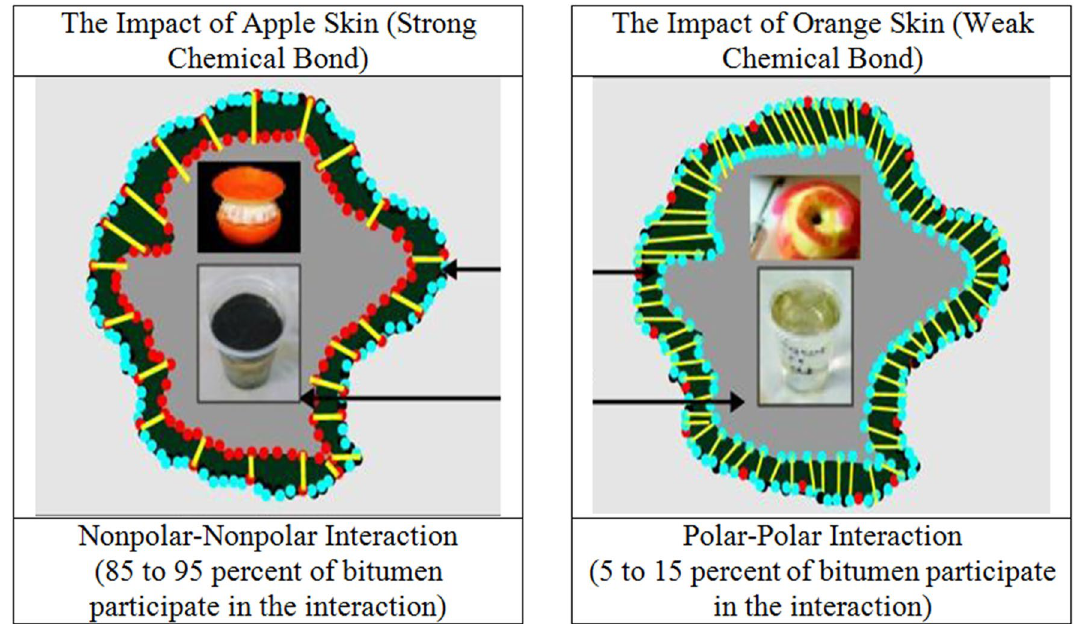
Fig. 3 The Impact of zycotherm chemical bond